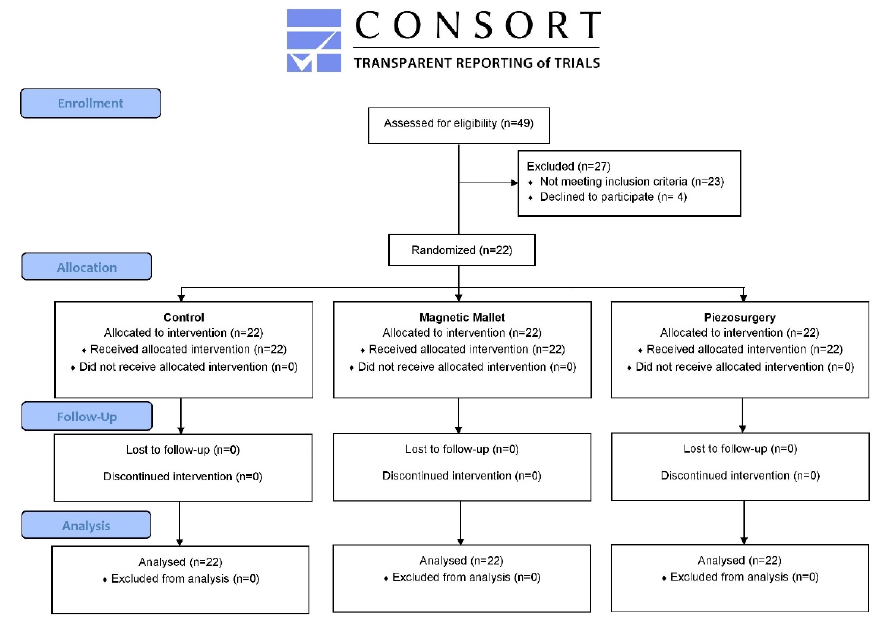
Figure 1. CONSORT flow diagram.